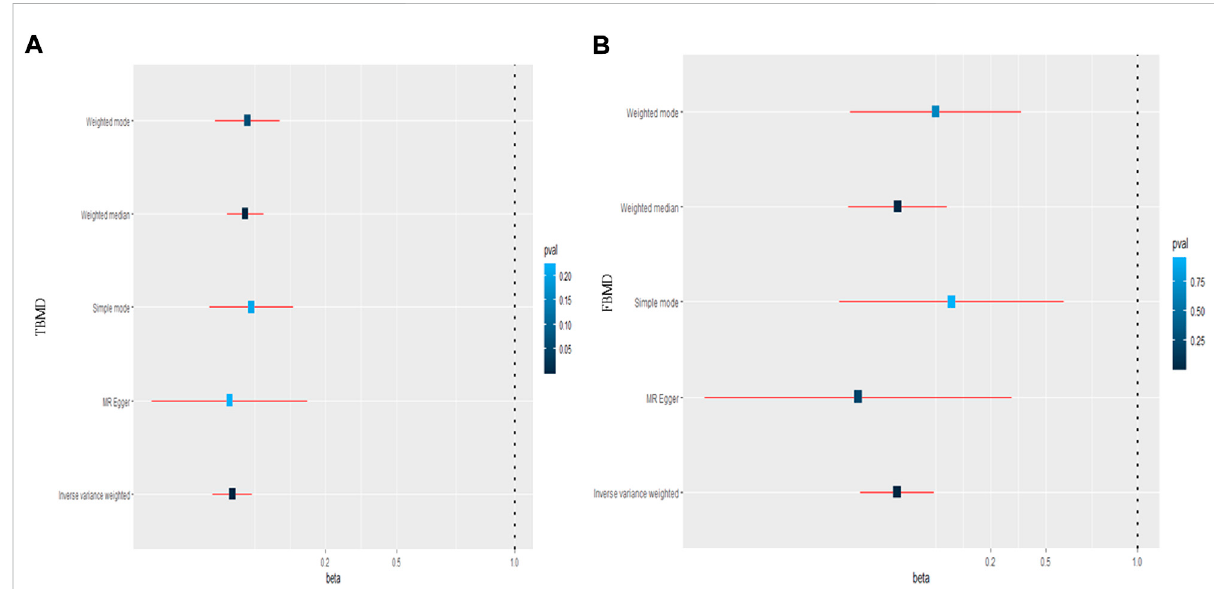
Thecausaleffectofhipcircumferenceontotalbodymineraldensity (A) andfemoralbodymineraldensity (B) .TBMD:totalbonemineraldensity; FBMD: femoral body mineral density.